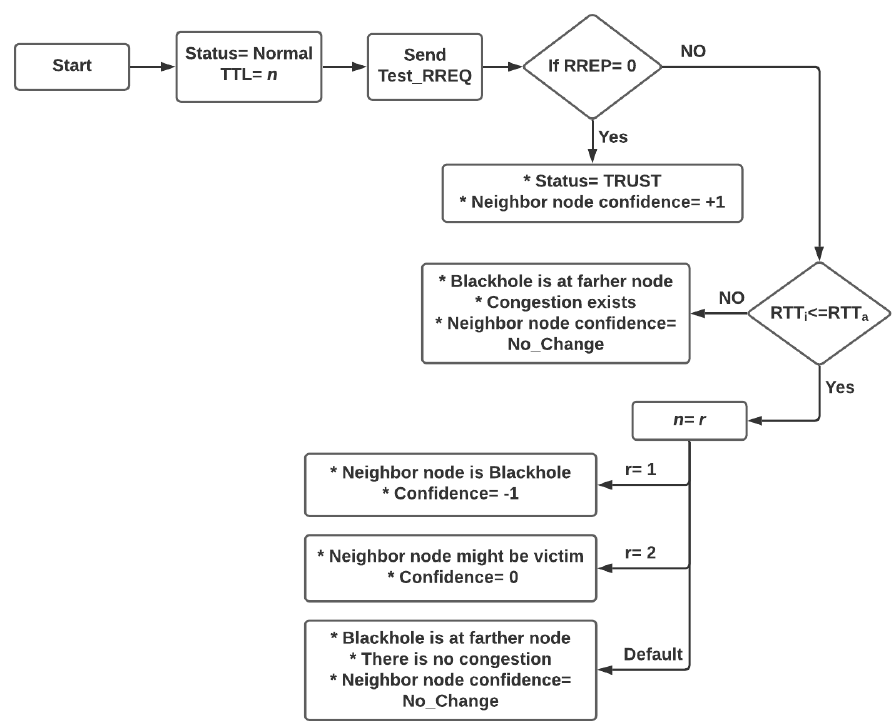
Figure 1. Flow chart of Enhanced Blackhole Resistance Method.